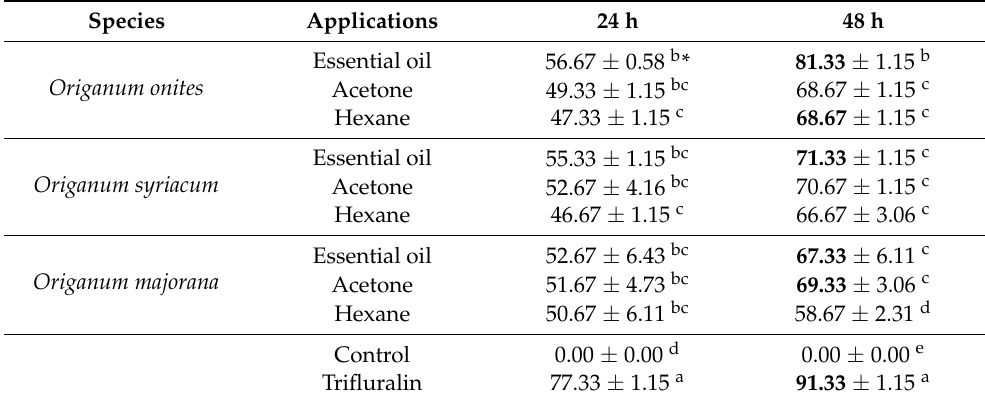
Table 5. The mortality rate (%) of Rumex crispus in nursery. Species